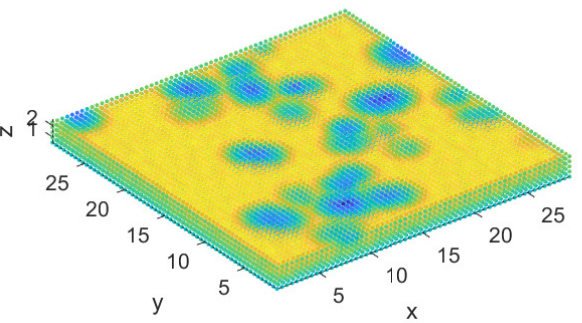
Figure 6. Distance map. The warmer colors represent greater distances (20 random